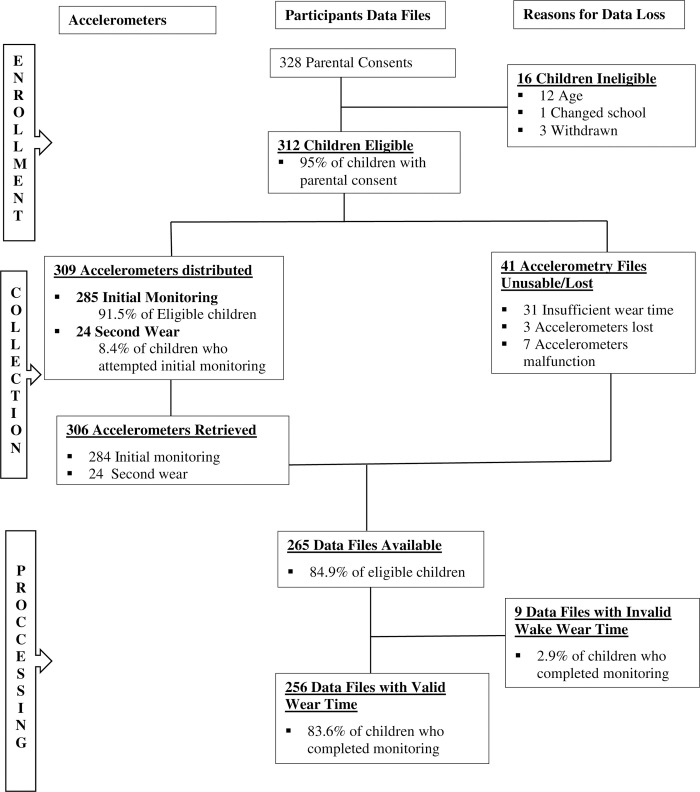
Participant flow chart reflecting accelerometry stages of participant enrollment, data collection, data processing and reasons for data loss at each stage (adapted from Tudor-Locke et al. 2015).